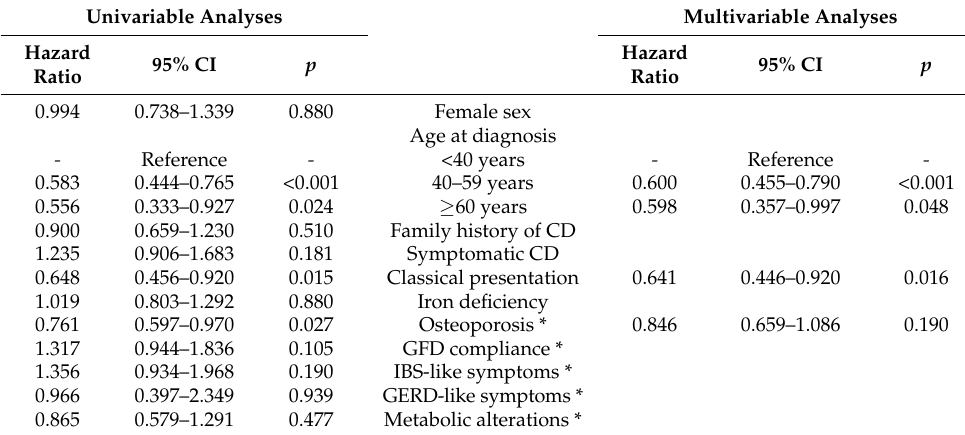
Table 3. Predictors of risk of late drop-out according to the multivariable Cox model with time- dependent